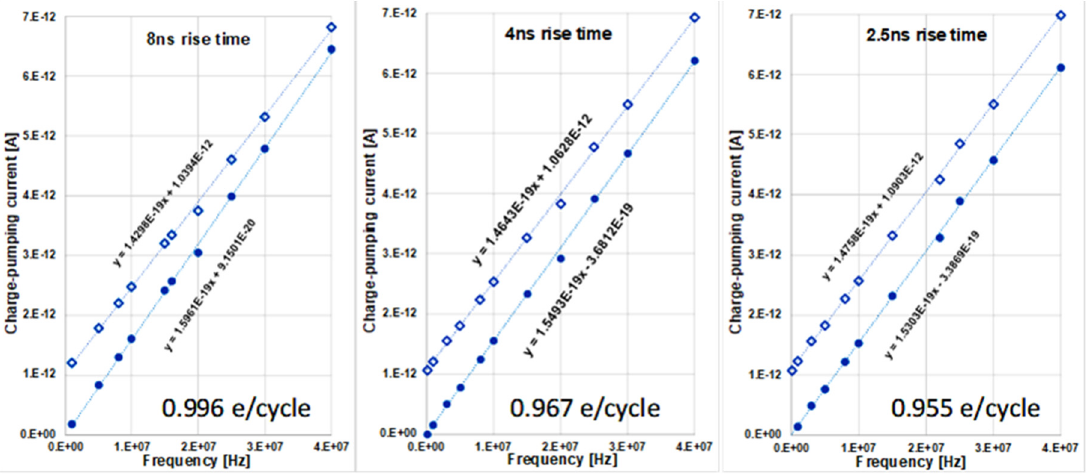
Figure 2. Measured and leakage corrected charge-pumping current as a function of frequency and their corresponding least square fits for three different rise/fall times. The charge per cycle at the bottom is extracted from the slope of the leakage corrected least square fit line, dividing by 1.6022 × 10 − 19 Coulomb.